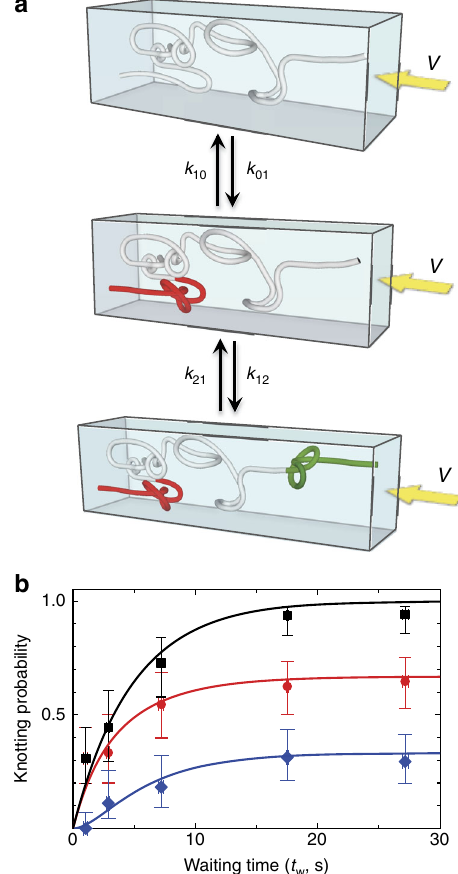
Fig. 3 Knot formation kinetics. a The probability for fi nding no knots (top), forming 1 knot (middle), and 2 knots (bottom) are related through the transition rates k ij from a state with i knots to a state with j knots. The transition rates de fi ne a set of coupled rate equations (see Supplementary Note 4). b The probability of knot formation as a function of waiting time at average barrier extension R b ≈ 0.13 with fi ts to the kinetic model. The black squares give experimental measurements for total probability of forming an event with any number of knots. The red circles and blue diamonds give respectively measurements of one-knot and two-knot event probabilities. The continuous lines represent the fi ts to the time-dependent knotting probabilities predicted by the rate equations. Each data point is determined from the average result of ~10 – 15 events. The vertical error bars on probability have been calculated using a Wilson-score interval with a one- sigma con fi dence interval 47 (See Supplementary Note 13); the horizontal error bars show the error on the mean for t